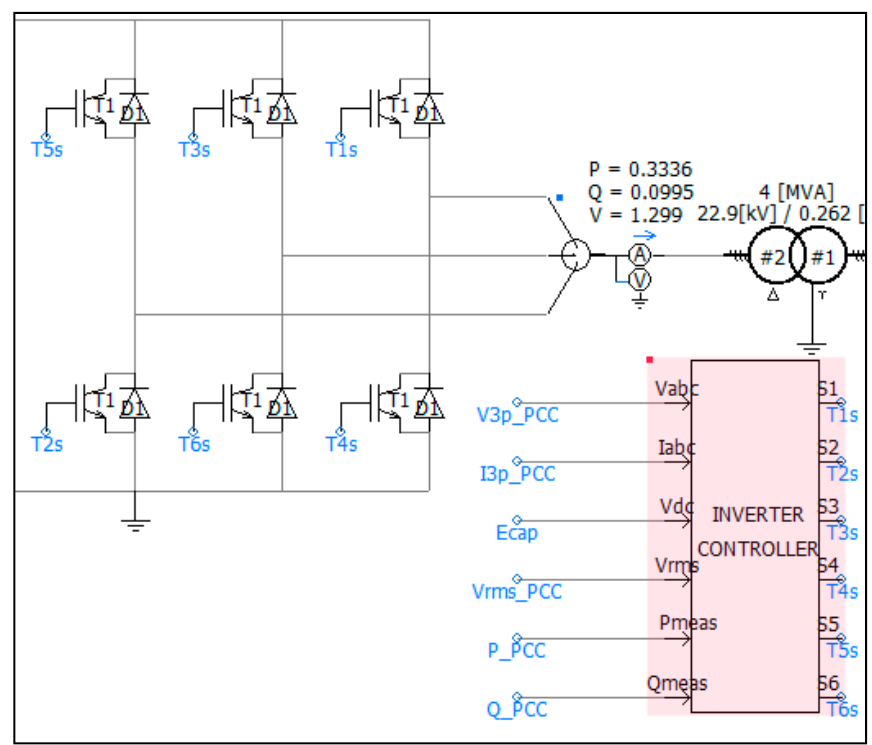
Figure 35. DC/AC inverter in PSCAD. Figure 35. DC / AC inverter in